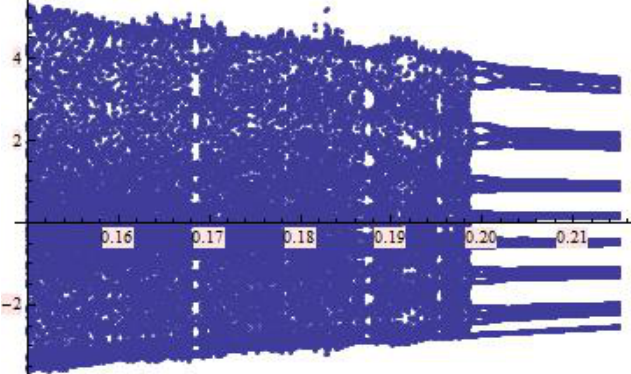
Figure 4. B.D. in ( β − x ) —plane, β between 0.15 and 0.215, α = − 2.1 and the initial conditions ( 0.1,0.2 )